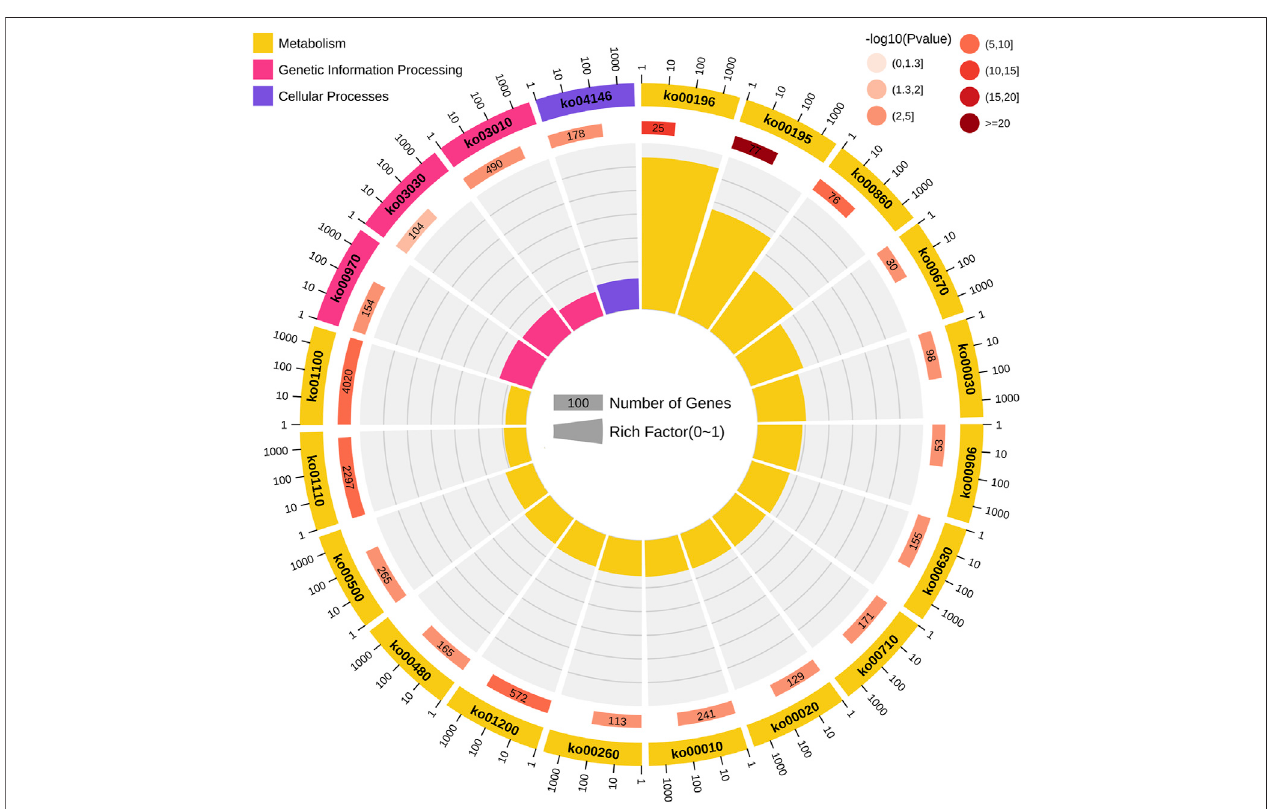
FIGURE 4 | Kyoto Encyclopedia of Genes and Genomes (KEGG) pathway enrichment analysis of genes among the four modules with high correlation. From the outermostcircletotheinnercircle:the fi rstcirclerepresentsthepathofthetop20enrichment,andtheoutsideofthecircleisthecoordinaterulerofthenumberofgenes. Different colors represent different classes. Yellow represents metabolism; pink represents genetic information processing; and purple represents cellular processes. Thesecondcirclerepresentsthenumbersand p